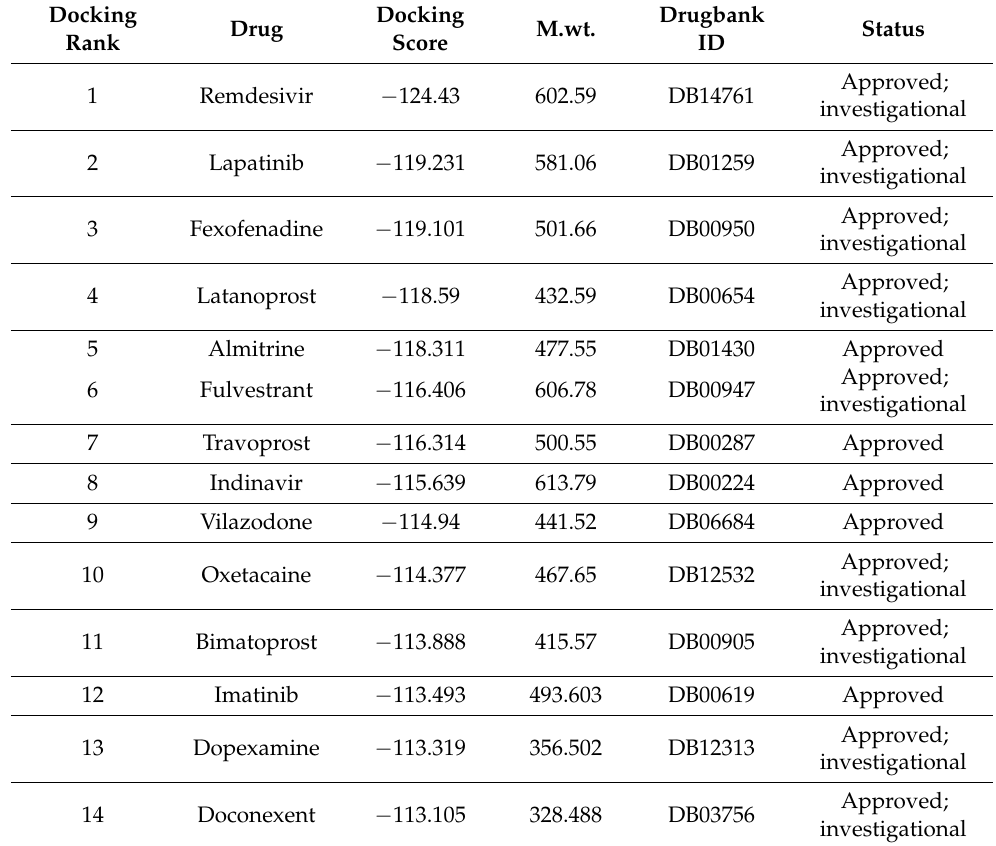
Table 2. The best enriched 1% of the VS results for FDA-approved drugs against Fascin (PDB ID: